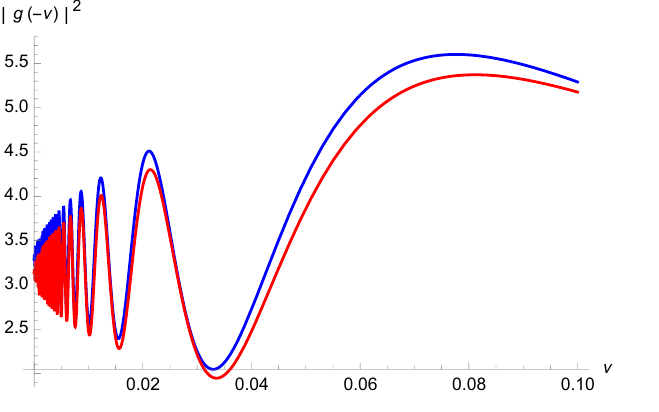
Figure 3 . Zoom in of the oscillating part of figure 2. These oscillations are nonexistent in the de Sitter stage which has a thermal or near thermal